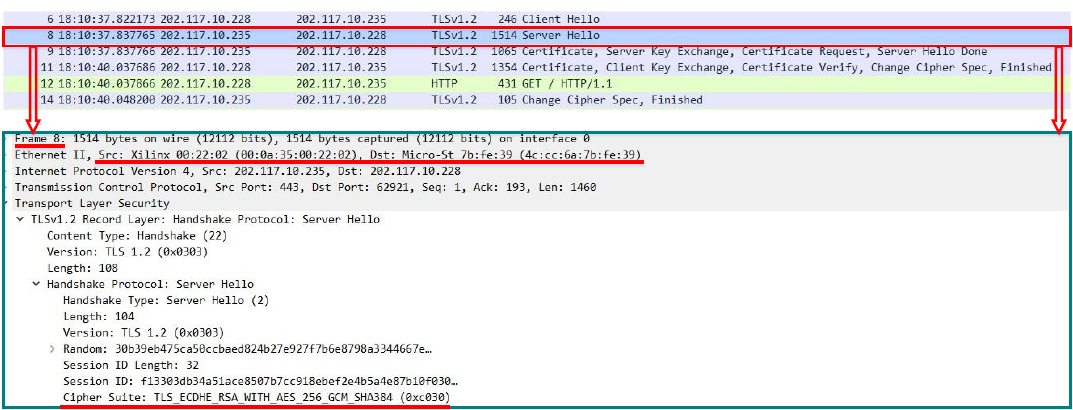
Figure 5. The message exchange procedure of client-aware negotiation based on renegotiation with highest security strength requirement.